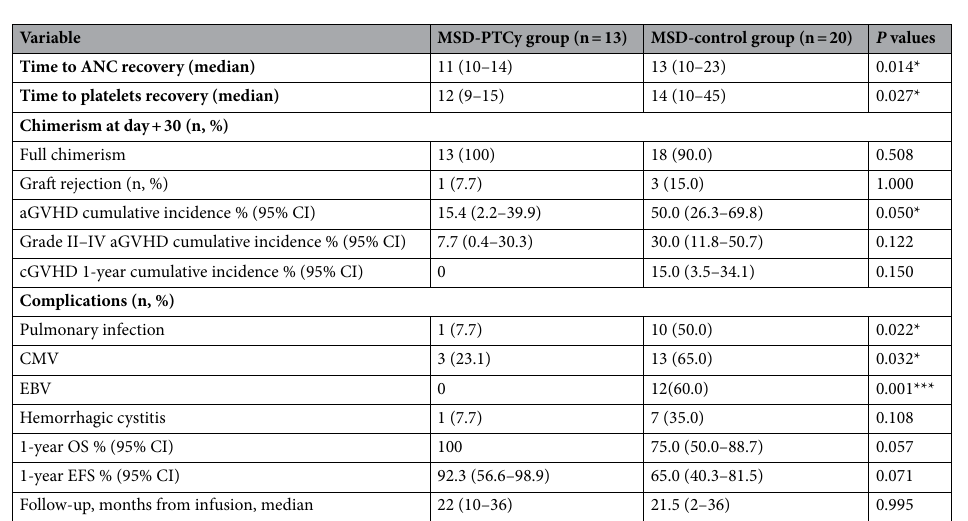
Figure 2. Cumulative incidence of graft-versus-host disease (GVHD). ( A ) Cumulative incidence of acute GVHD at day + 100 in MSD-PTCy group compared to MSD-control group. ( B ) Cumulative incidence of chronic GVHD at 1 year in MSD-PTCy group compared to MSD-control group. ( C ) Cumulative incidence of acute GVHD at day + 100 in haplo-HSCT group compared to haplo-control group. ( D ) Cumulative incidence of chronic GVHD at 1 year in haplo-HSCT group compared to haplo-control group.